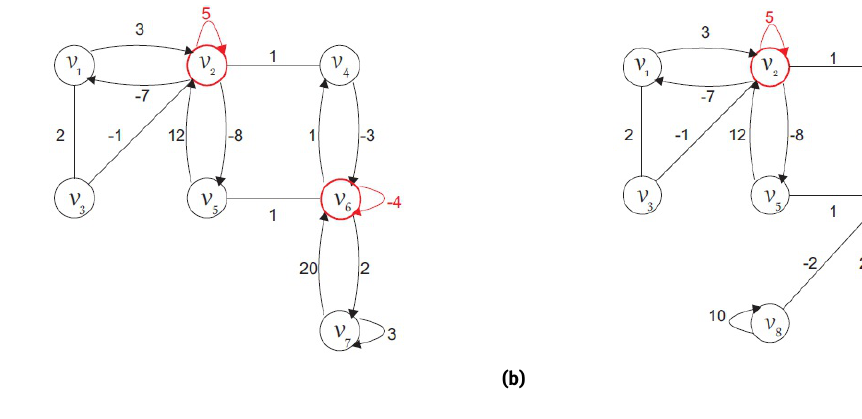
The cut-entries and the cut-vertices are shown in red in the matrices M 1 and M 2 , as well as in their cor- responding digraphs G ( M 1 ) and G ( M 2 ) . Note that, when a uv = a vu ≠ 0 , we simply denote edges ( u , v ) and ( v , u ) with an undirected edge ( u , v ) with weight a uv . As an example, in G ( M 1 ) the edge ( v 1 , v 3 ) and ( v 3 , v 1 ) are undirected edges. The digraph G ( M 1 ) , depicted in the Figure 1(a), has blocks B 1 , B 2 and B 3 which are induced subdigraphs on vertex subsets { v 1 , v 2 , v 3 } , { v 2 , v 4 , v 5 , v 6 } and { v 6 , v 7 } , respectively. Here, cut-vertices are v 2 and v 6 with cut-indices 2. Similarly, the digraph G ( M 2 ) in the Figure 1(b), has blocks B 1 , B 2 , B 3 and B 4 on ver- tex sets { v 1 , v 2 , v 3 } , { v 2 , v 4 , v 5 , v 6 } , { v 6 , v 7 } and { v 6 , v 8 } , respectively. Here, cut-vertices are v 2 and v 6 with cut-indices 2 and 3 ,